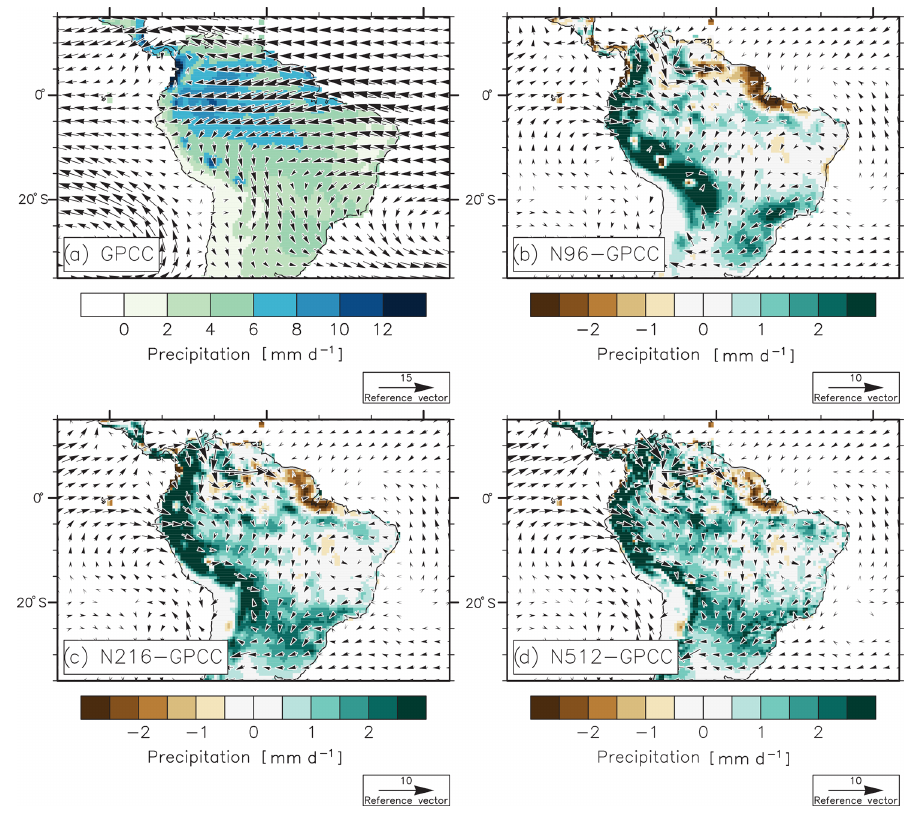
Figure 1. (a) Observed mean annual precipitation (GPCC; mmd − 1 ; colours) and 850hPa wind (NCEP; ms − 1 ; vectors), averaged over the period 1950–2014. Bias in precipitation and 850hPa wind in (b) N96 (i.e. N96–GPCC), (c) N216 (i.e. N216–GPCC), and (d) N512 (i.e. N512–GPCC). In panels (a) , (b) , and (c) biases in precipitation are shown when statistically significant in all of the three members according to a Student’s t test and a 95% confidence